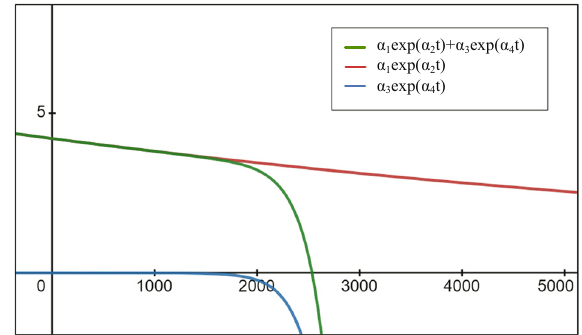
Figure 1: Geometry of the double exponential